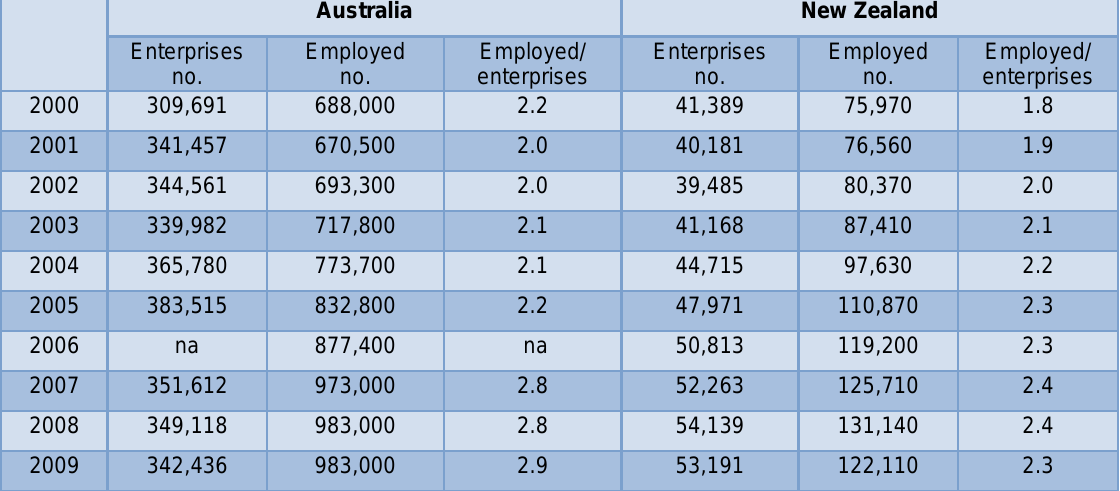
Table 3 Average size of construction enterprises in New Zealand and Australia Source: Statistics New Zealand, Business demography statistics. Australian Bureau of Statistics, Australian industry, cat. no.